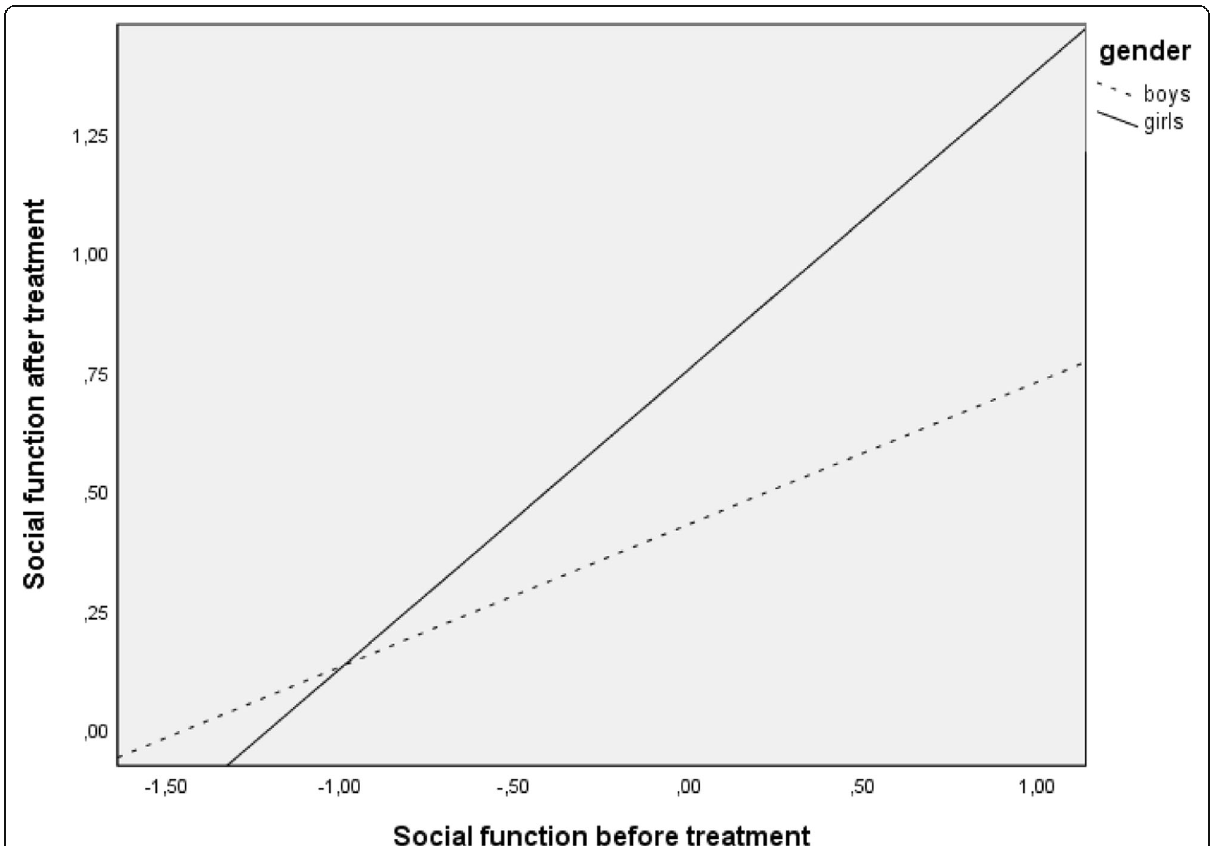
Fig. 2 Relationship between social function before and after treatment depends on